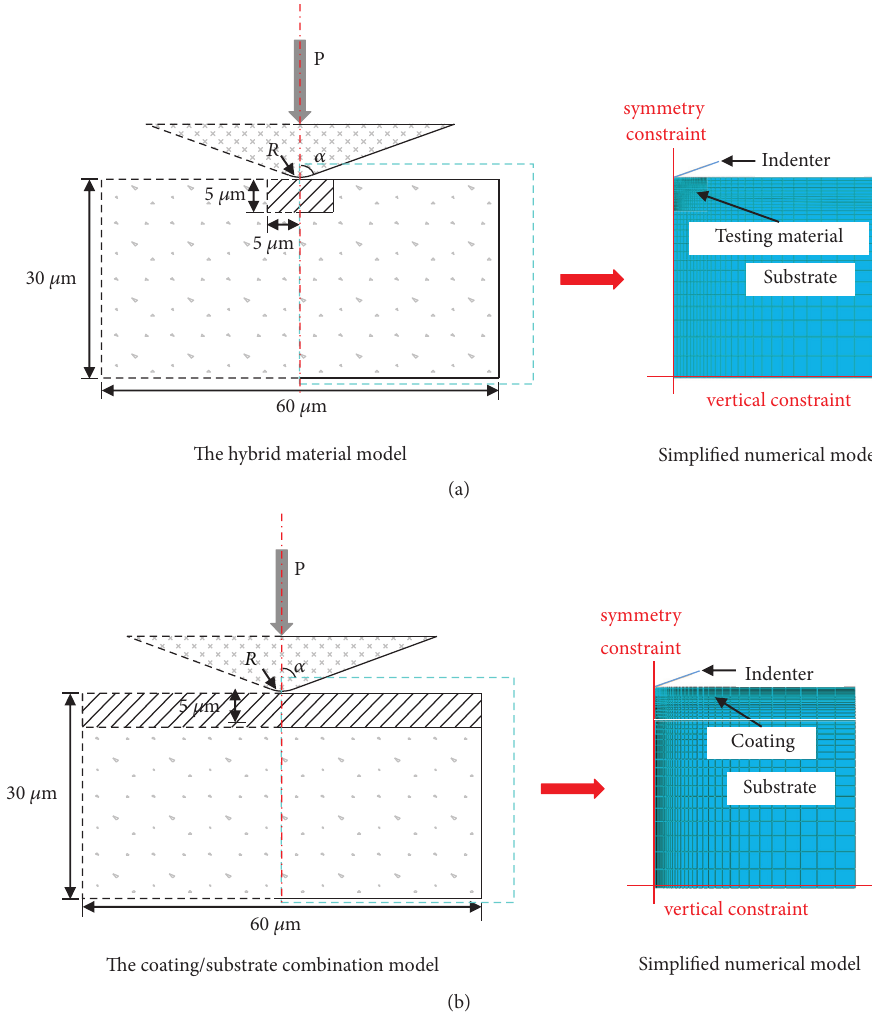
Figure 2: Numerical models used in the simulation. R � 100nm and α � 70.3 °